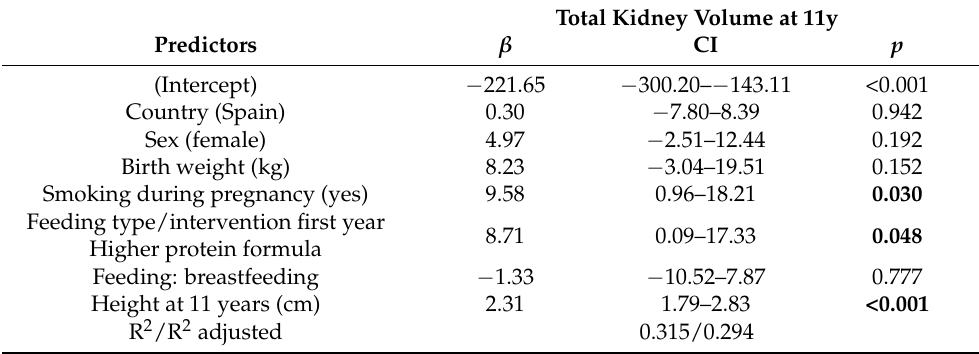
Table 3. Linear regression models to predict kidney volume (cm 3 ) at 11 years of